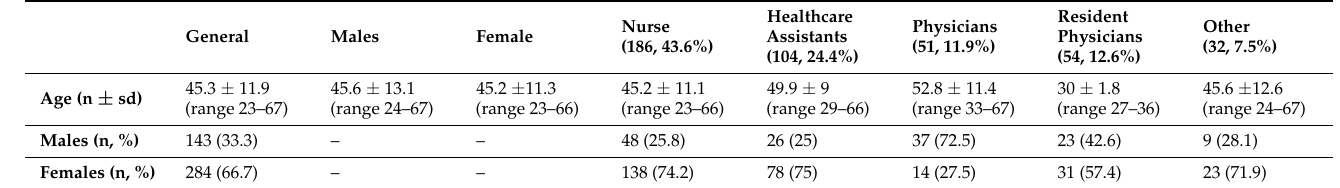
Table 1. Main variables analyzed in the study, for the general sample and for professional